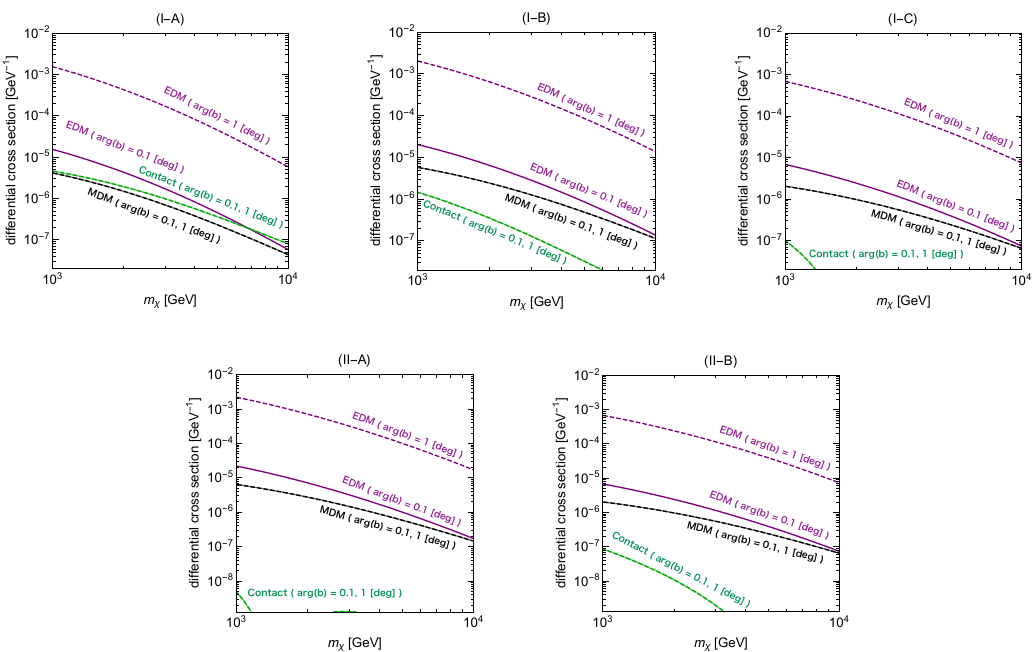
Figure 6 . The (cid:12)rst, second, and third terms in the square bracket in eq. (4.8) as functions of DM mass in black, purple, and green lines, respectively. Here we take the same parameter sets as in (cid:12)gure 2, with the solid (dashed) lines correspond to arg( b ) = 0 : 1 (1) degrees, and (cid:12)x the rest of the parameters in eq. (4.8) to be E = 30 keV, v rel = 232 km = s, Z = 54, A = 131, and m R (for 131